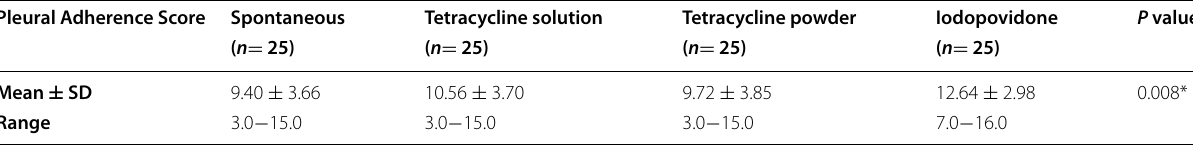
Table 7 Pleural Adherence Score by chest ultrasound 24 h after pleurodesis in the four study groups